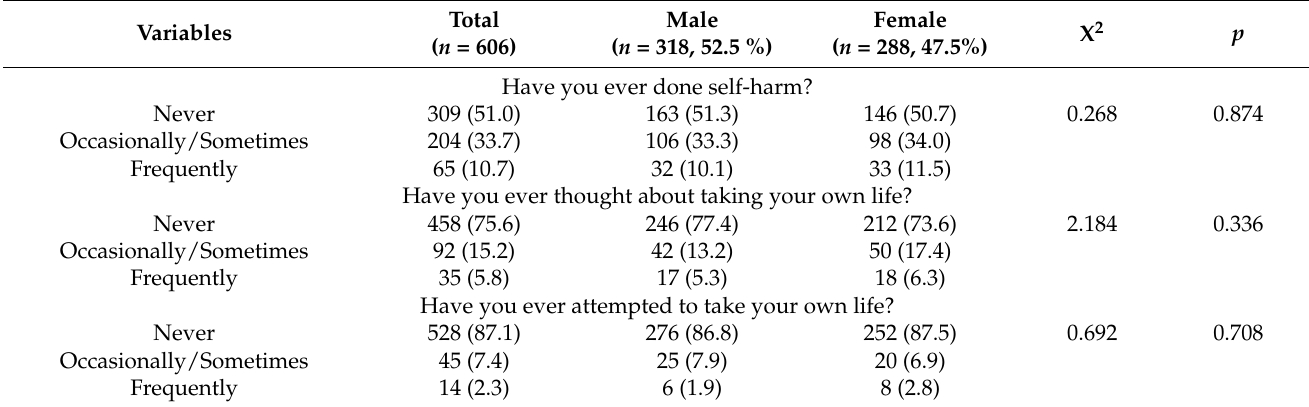
Table 3. Self-harm, suicidal ideation and suicide attempts among participants by